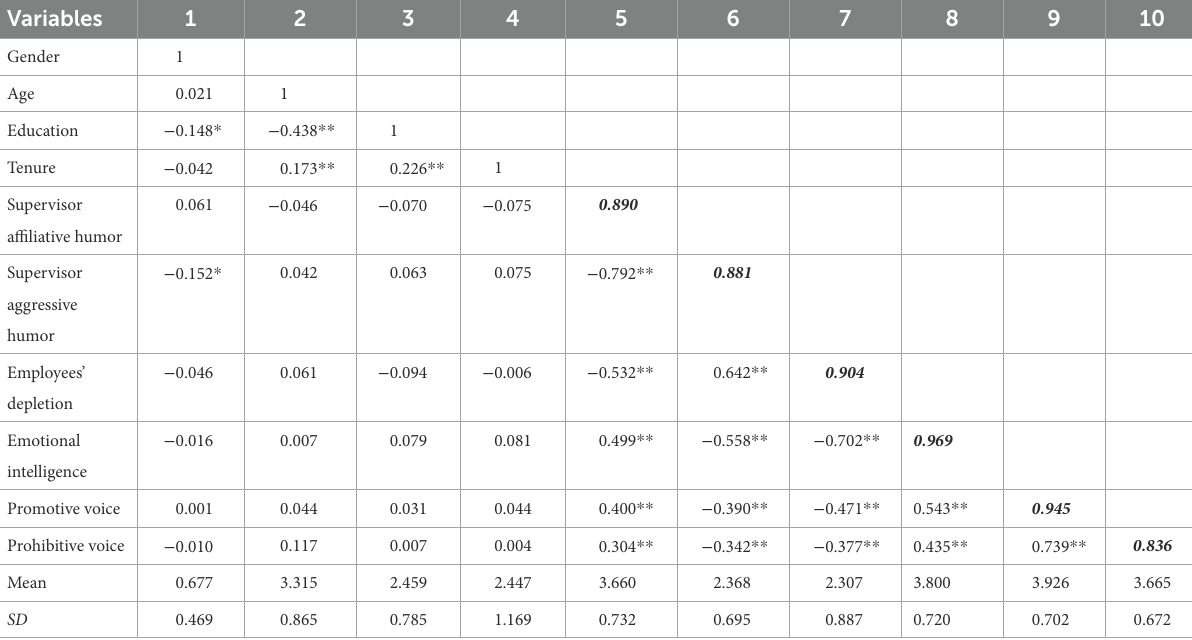
TABLE 2 Means, standard deviations, reliabilities, and